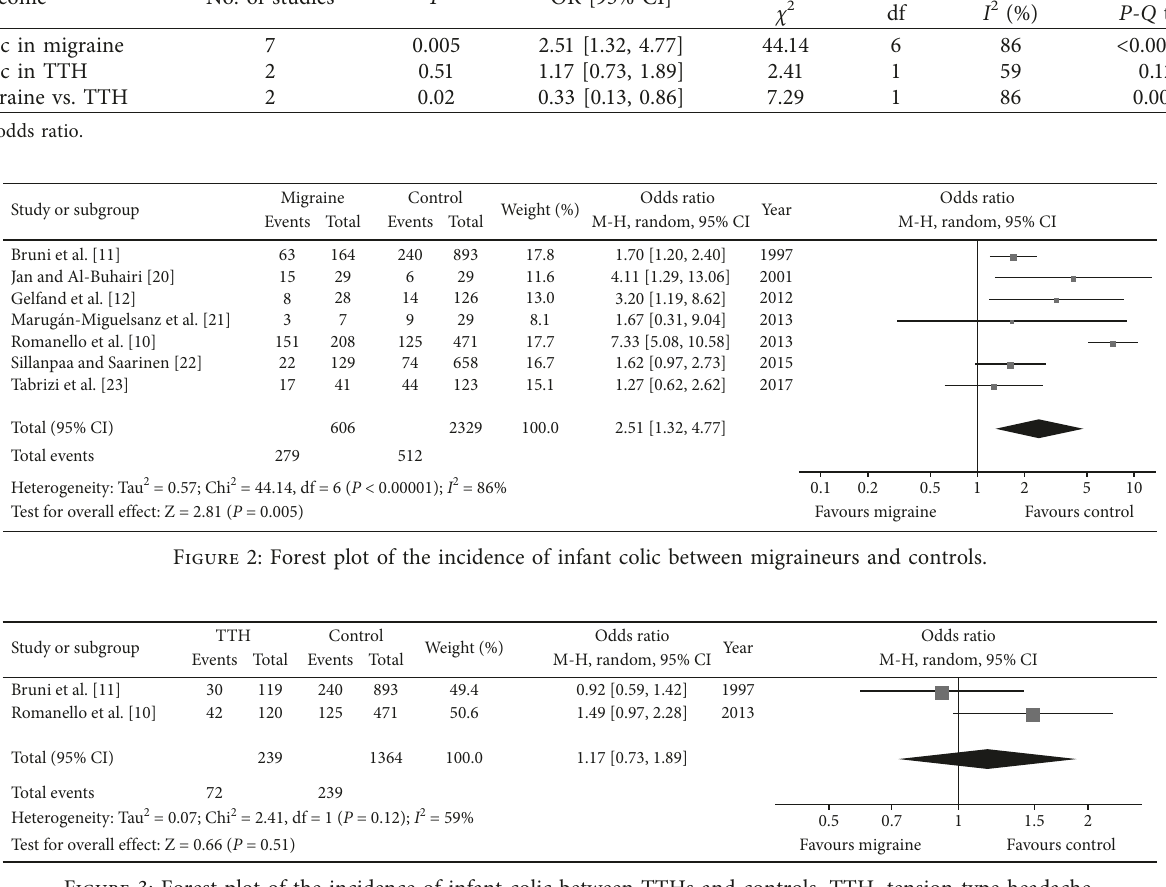
Figure 3: Forest plot of the incidence of infant colic between TTHs and controls. TTH, tension-type headache.